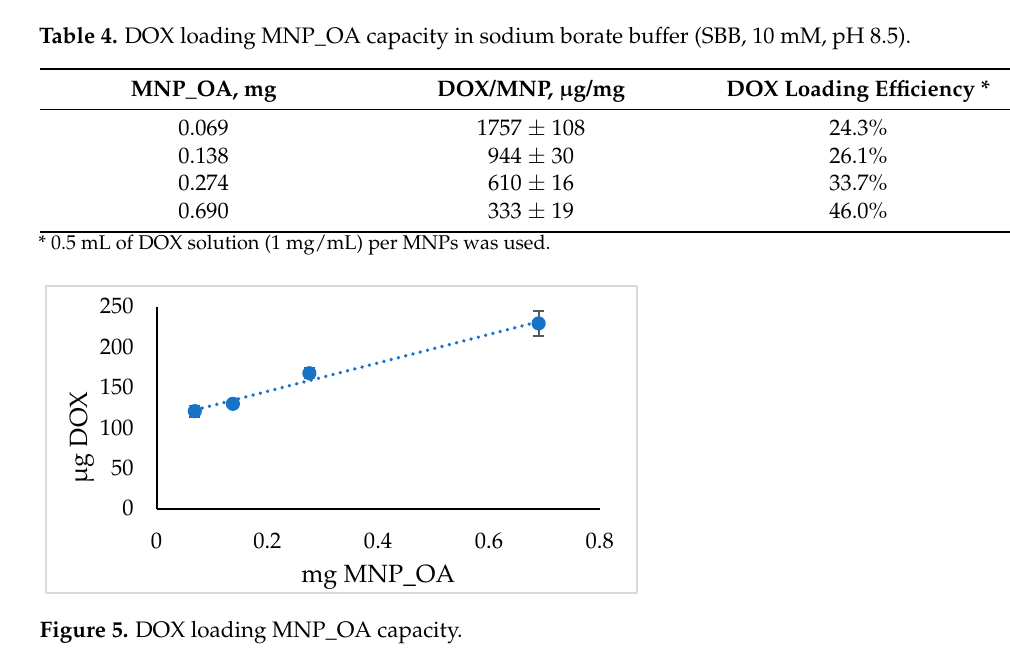
Figure 6. Hydrodynamic size variation of 0.13 mg/mL MNP_OA and MNP_OA_DOX evaluated by DLS for 48 h in 100 mM acetic buffer (pH 3 and 5), deionized water (Milli-Q), and cell medium